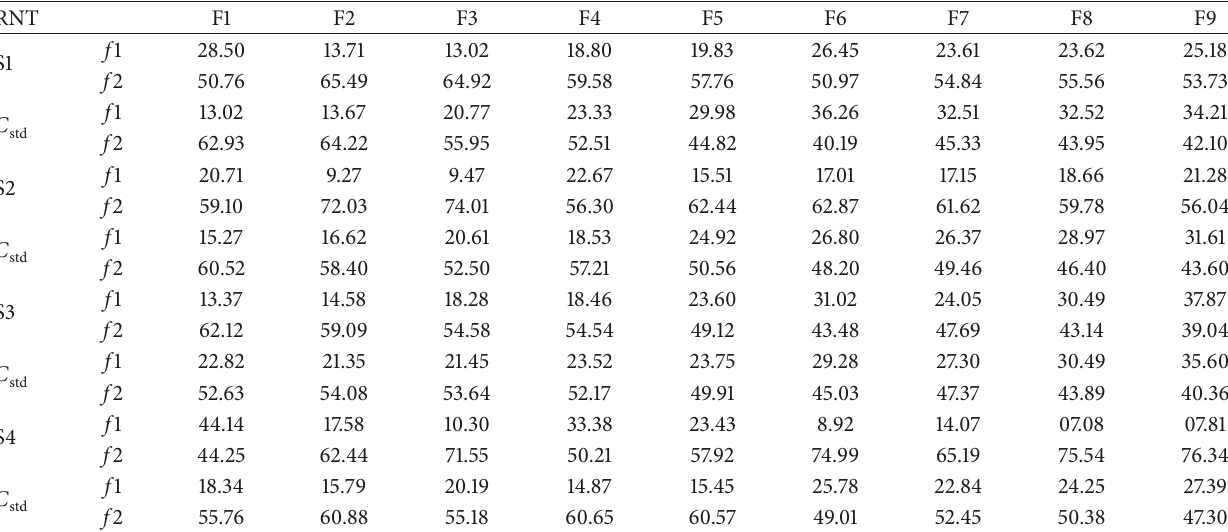
Table 5: Similarity ( f 2 ) and difference factor ( f 1) for all